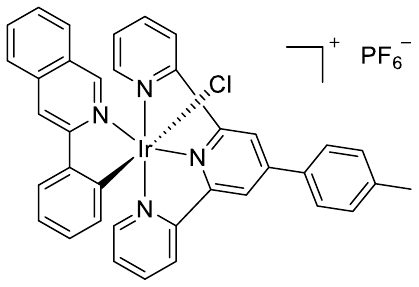
Figure 10. Chemical structure of the Ir complex evaluated by Sadler and co-workers.